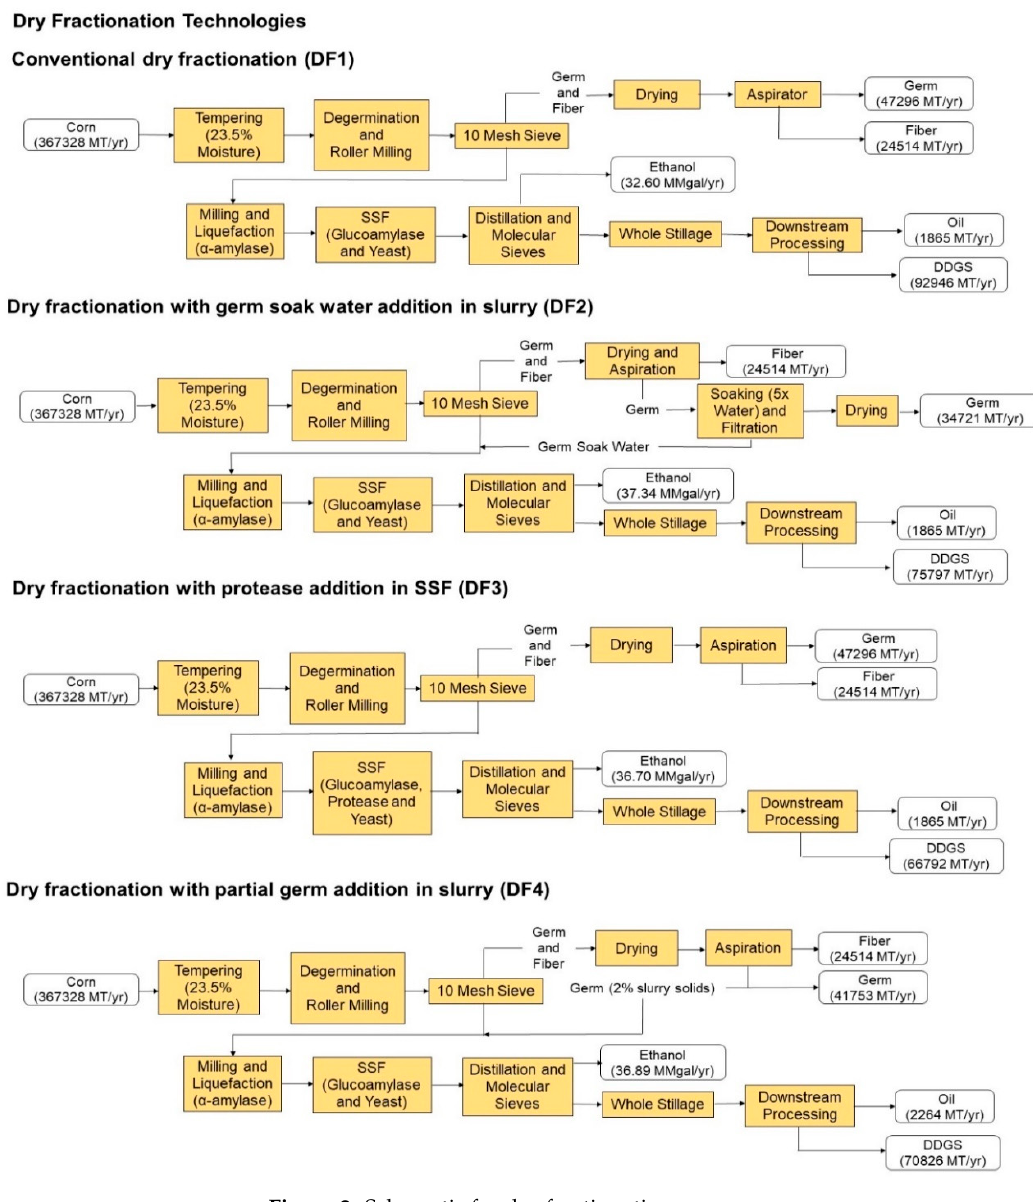
Figure 2. Schematic for dry fractionation processes.